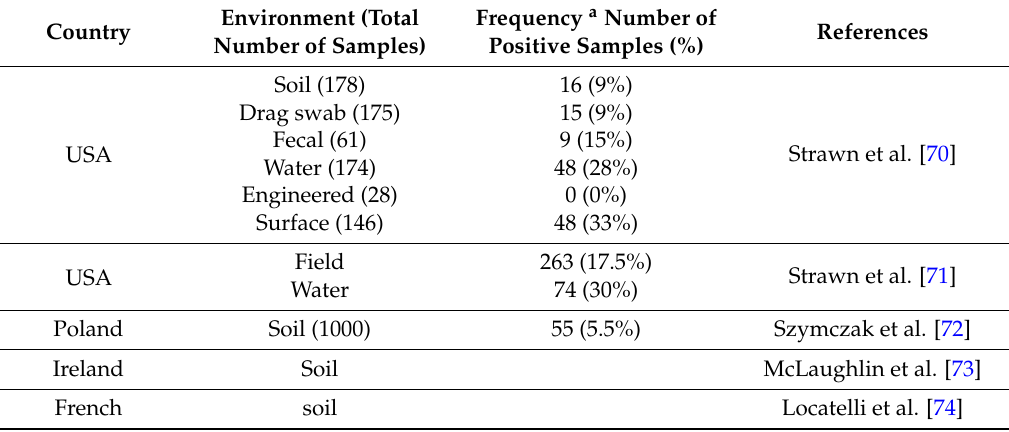
Table 2. Prevalence of L. monocytogenes in a fresh produce growing